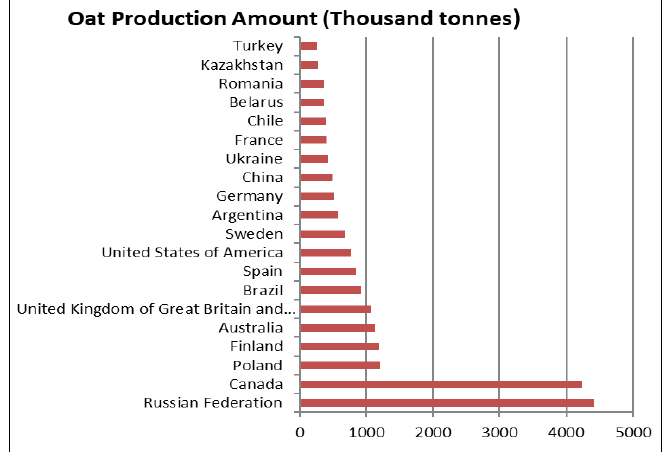
Figure 2: Oat production in the world (2019). Source: [22].